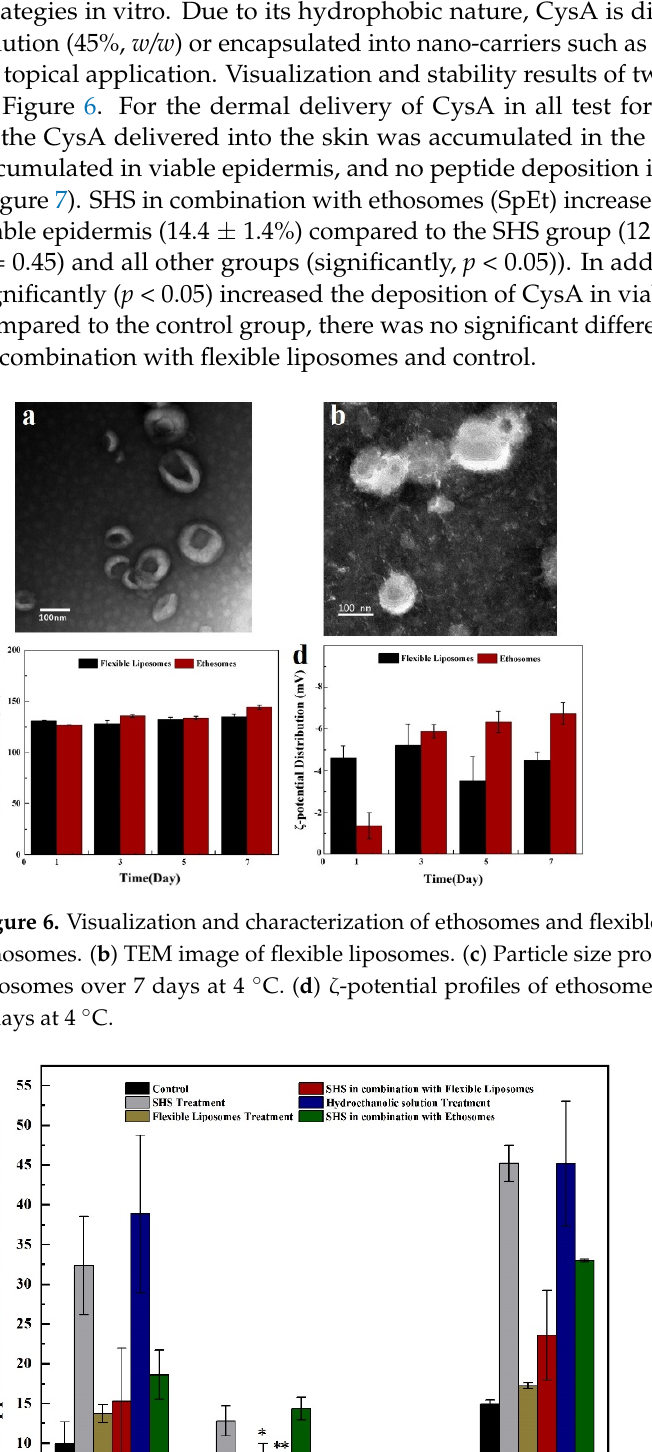
Figure 5. The blood glucose level (BGL) profiles and plasma insulin level (PIL) profiles induced by different treatment strategies in vivo. ( a ) BGL profiles in diabetic rats. ( b ) PIL profiles in diabetic rats.